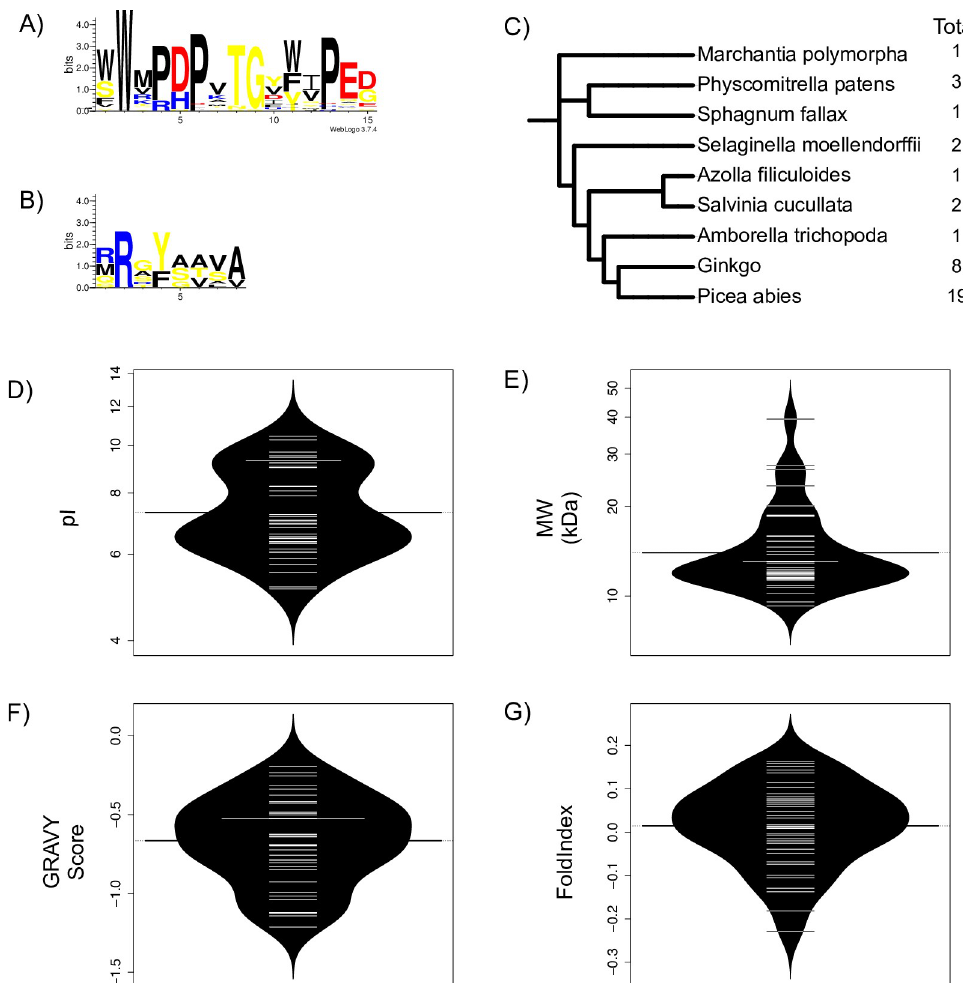
Fig 5. LEA3 proteins in lower plants. A) W-motif in lower plants in LOGO representation. B) RRGYA 4 -motif in lower plants in LOGO representation. Amino acids are color-coded by their group type. Blue—positively charged (Lys, Arg, His); red—negatively charged (Asp, Glu); black—hydrophobic (Ala, Val, Leu, Ile, Pro, Phe, Met), yellow—polar (Gly, Ser, Thr, Tyr, Cys, Asn, Gln). The heights of the amino acids correspond to their level of conservation at that position. C) Species tree of LEA3 proteins in lower plants. The right-hand column shows the total number of proteins in each species. Bean plots of the D) isoelectric point (pI), E) molecular weight (MW), F) GRAVY score and G) FoldIndex score of LEA3 proteins in lower plants. The thin bars show the value of an individual protein, the wider black bar shows the mean value of an architecture, and the dotted line shows the mean value of all protein sequences. The violin shape shows the density of the property